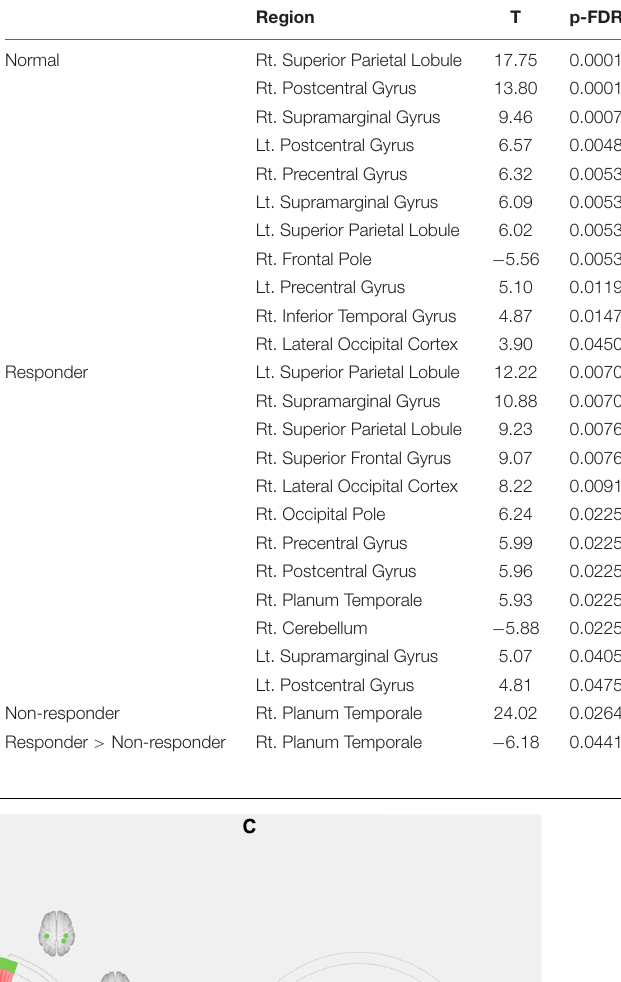
TABLE 2 | Regions significantly connected with the dorsal attention network in the region of interest analysis.